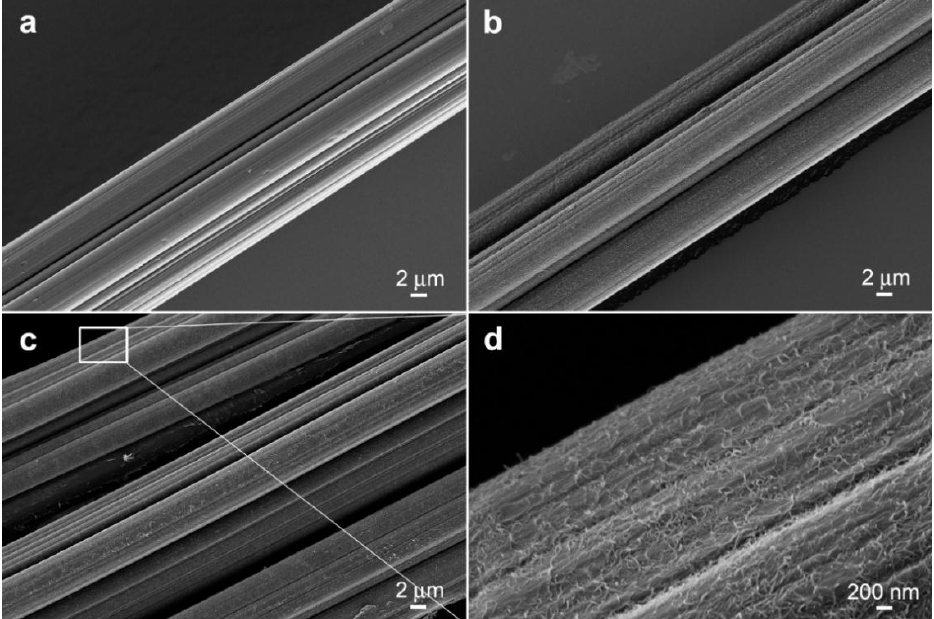
Figure 1. SEM images of the surface of ( a ) original cellulose fiber (viscose fiber) and MWCNT-coated cellulose fiber ( b – d ) dip coated with a 0.5 wt% CNT dispersion; ( b ) monofilament cellulose fiber; ( c ) multifilament cellulose fibers; and ( d ) well-formed MWCNT networks on the fiber